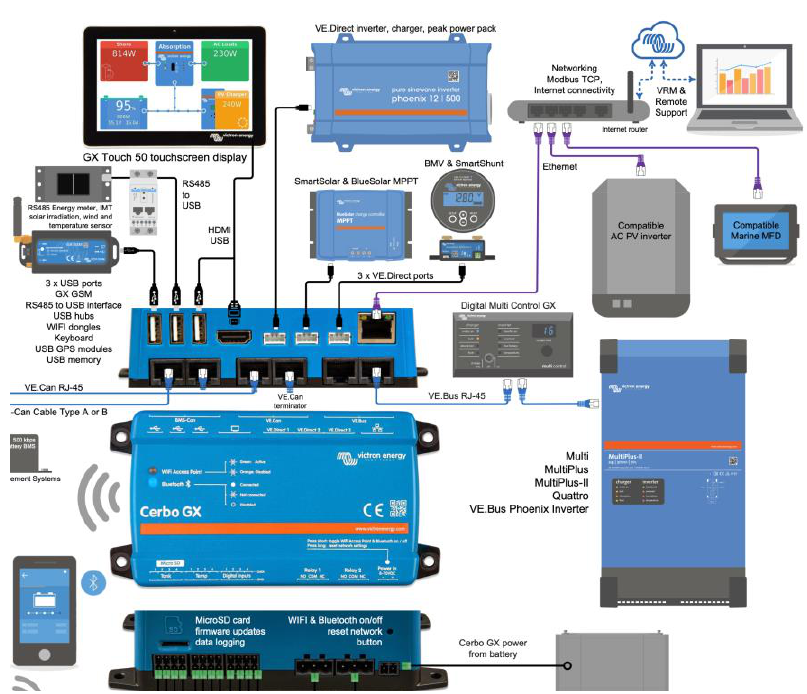
Figure 7. Cerbo GX configuration.